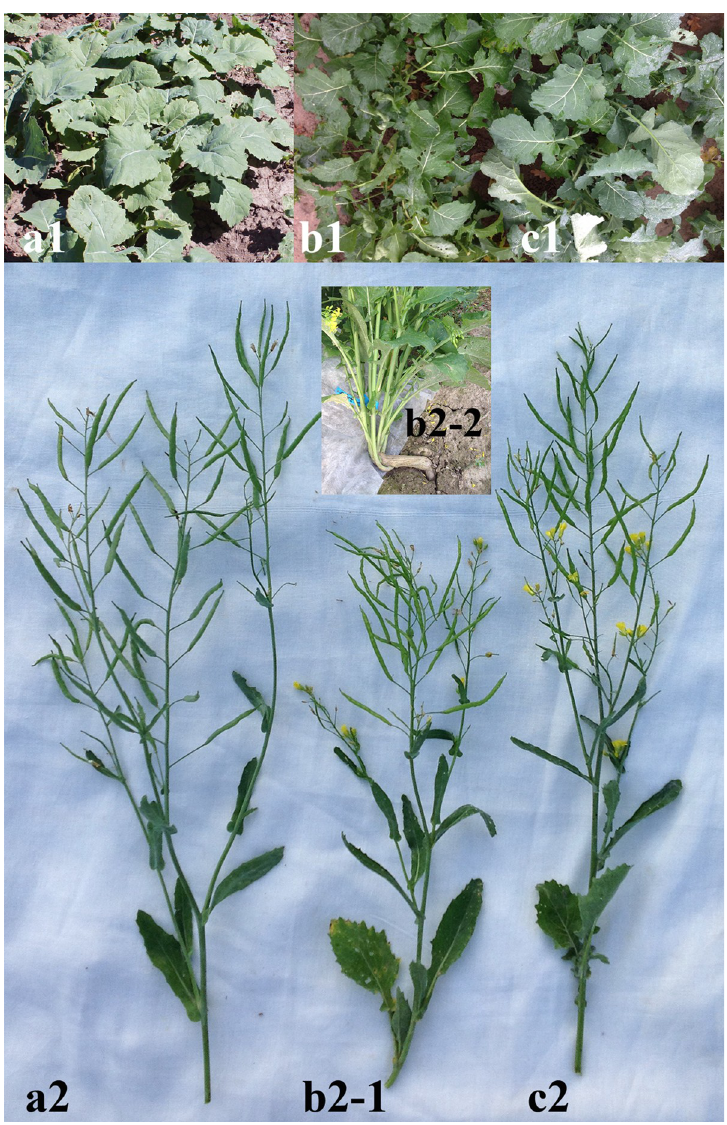
Fig 1. Plants of original B . napus cv. Vikros and its mutant progeny. Plants of B . napus cv. Vikros (a1), mutant plants of B . rapa -type (b1) and B . napus -type (c1) at the rosette vegetative growth stage; position and shape of siliqua in B . napus cv. Vikros (a2), in plants of B . rapa -type (b2-1) and B . napus -type (c2); a plant of B . rapa -type with a long hypocotyl (b2-2). (Table 1). Siliqua in B . rapa -like plants were thinner and grew more vertical (vs. in B . napus - type plants, the angle was about 45˚) (Fig 1).